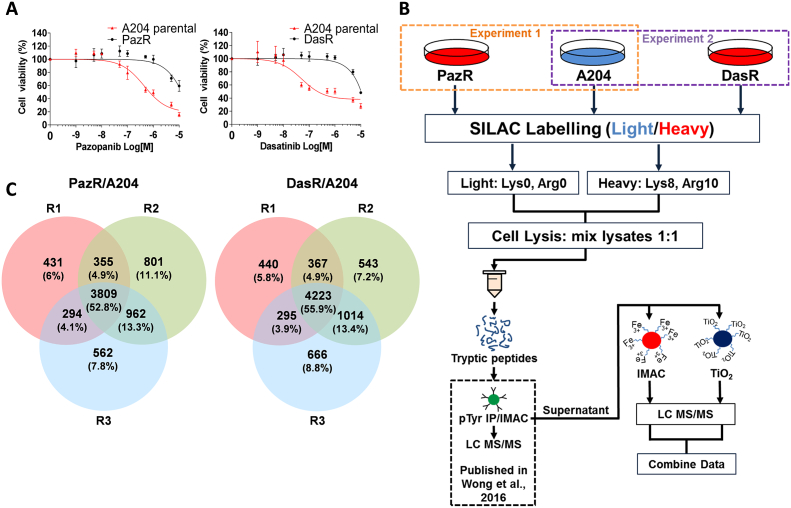
Experimental outline and phosphoprotome dataset overview. (A) Dose response curve of A204 parental and PazR cells to pazopanib and A204 parental and DasR cells to dasatinib respectively. (B) Schematic of sample preparation workflow. Pazopanib and dasatinib resistant A204 cell lines (PazR & DasR respectively) were generated and heavy SILAC labelled as previously described [12]. A204 parental cells were light SILAC labelled. After cell lysis, either heavy PazR or DasR were mixed 1:1 with light A204 parental lysate then reduced, alkylated and trypsin digested. The resulting peptides underwent phospho-tyrosine (pTyr) peptide immunoprecipitation, data previously published [12]. The supernatant from the immunoprecipitation was further enriched with immobilised metal affinity chromatography (IMAC) or titanium dioxide (TiO2) prior to liquid chromatography tandem mass spectrometry analysis (LC MS/MS). (C) Venn diagrams show distribution of phosphorylation sites across three biological replicates (R1, R2 and R3) in PazR/A204 and DasR/A204 experiments.